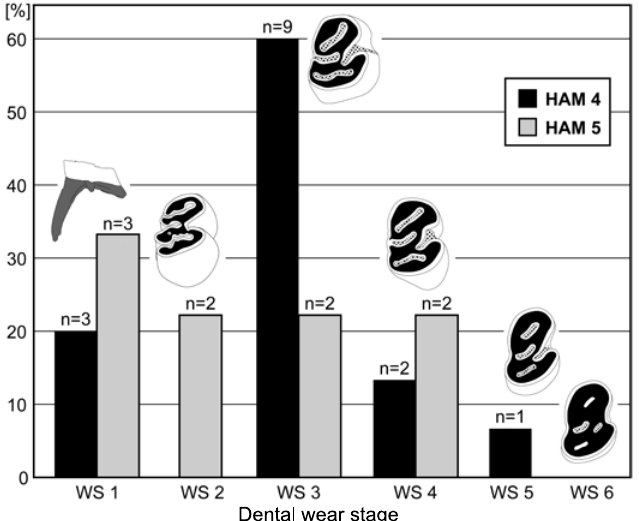
Fig. 11. Mortality profiles (age-frequency distribution) of the beaver Ste- neo fiber depereti Mayet, 1908, from the early Late Miocene locality Ham- mer schmiede (Bavaria, Germany) based on lower dp4 and p4 tooth po- sitions from the local stratigraphic levels HAM 5 and HAM 4. Each bar corresponds to an age class, defined by occlusal dental wear stages (WS 1–6). Vertical axis represents the percentage of